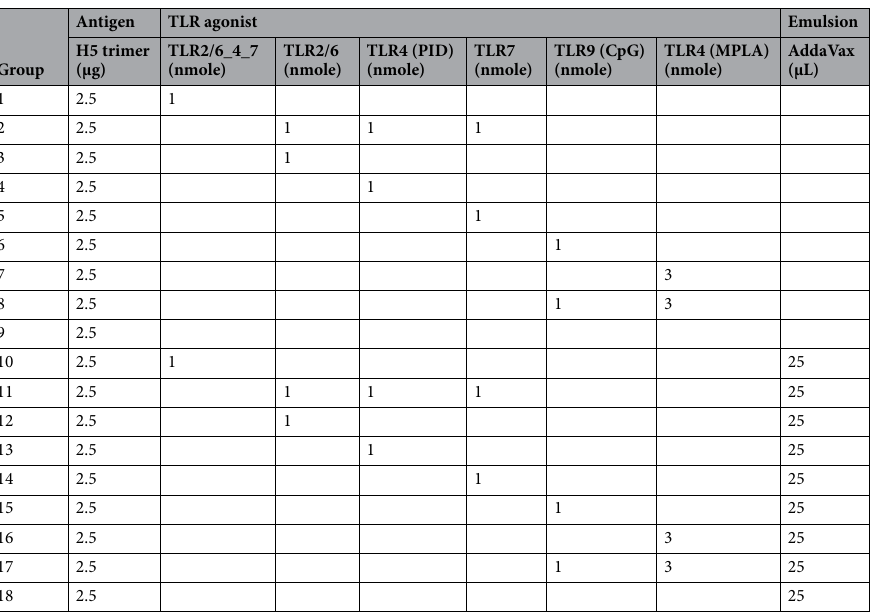
Table 1. Formulations used for adjuvant screen. Groups of female C57Bl/6 mice (N = 4 per group) were administered antigen and TLR agonist(s) to a final volume of 50 μL in PBS per mouse (groups 1–9) or 25 μL in PBS and an equal volume of AddaVax emulsion added (groups 10–18), and administered via the s.c. route (base of